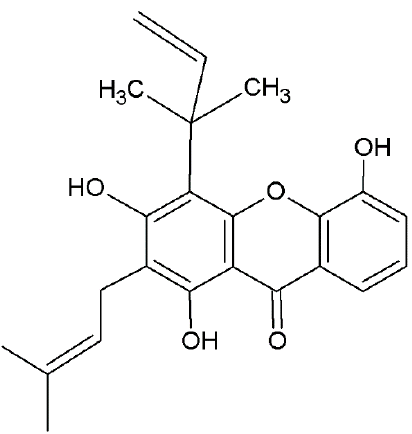
Figure 4. Structure of allanxanthone A, prenylated xanthone.